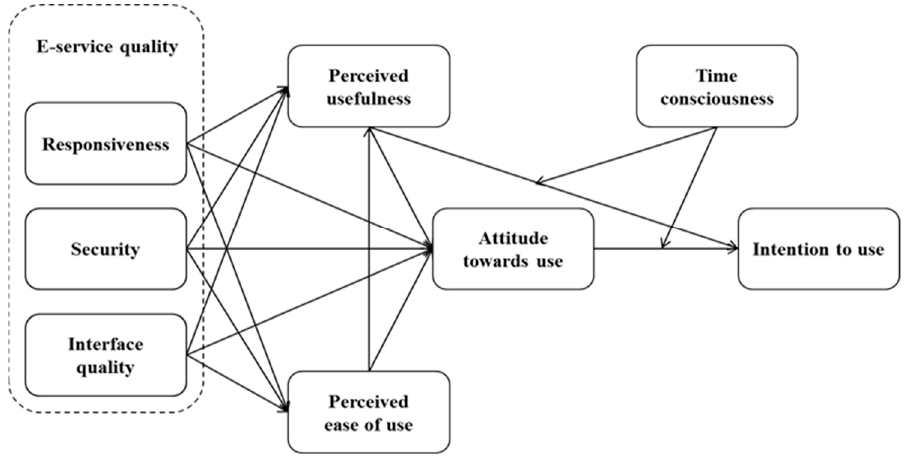
Figure 1. Research